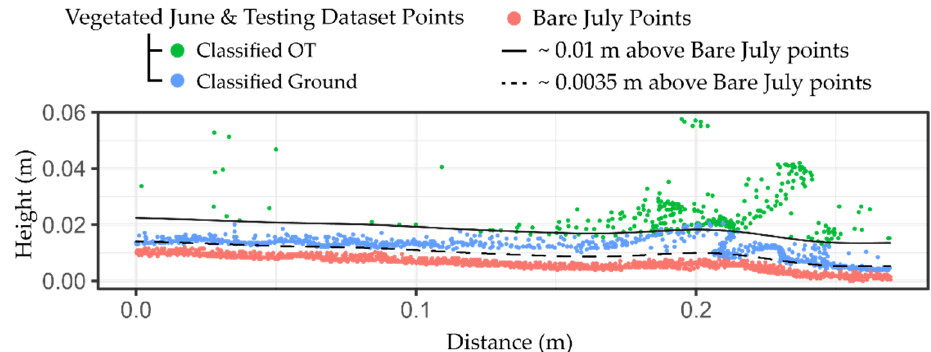
Figure 5. A cross section example of the classification of the testing dataset using the 0.01 m threshold. A distance above the bare July 3D point cloud approximate to the registration’s mean absolute error of 0.0035 m is shown by the dashed line.